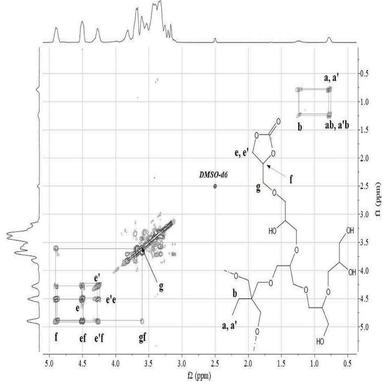
1 H–1 H COSY NMR spectrum (500 MHz, DMSO‑d6) of hyperbranched polyglycerol containing five-membered cyclic carbonate groups.